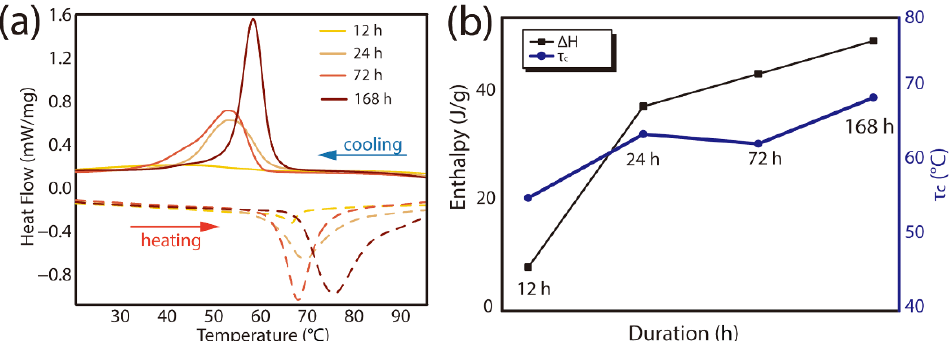
Figure 6. ( a – d ) SEM images of hydrothermal samples with different precursor concentrations at 260 °C with 60 μL N 2 H 4 ·H 2 O and 24 h duration.